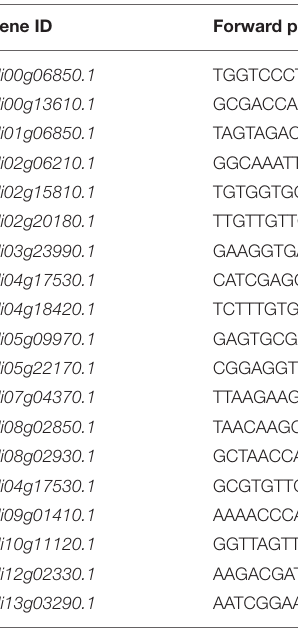
TABLE 2 | List of primers used for qRT-PCR